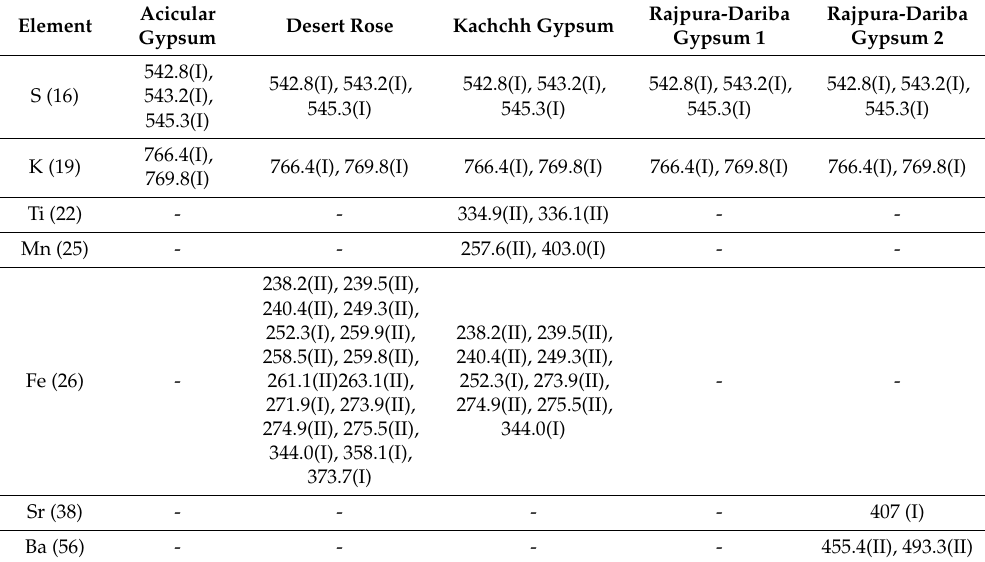
Table 2. Spectral wavelengths of atoms observed in laser induced breakdown spectroscopic spectra of di ff erent gypsum samples: Sulfur, potassium, titanium, manganese, iron, strontium,